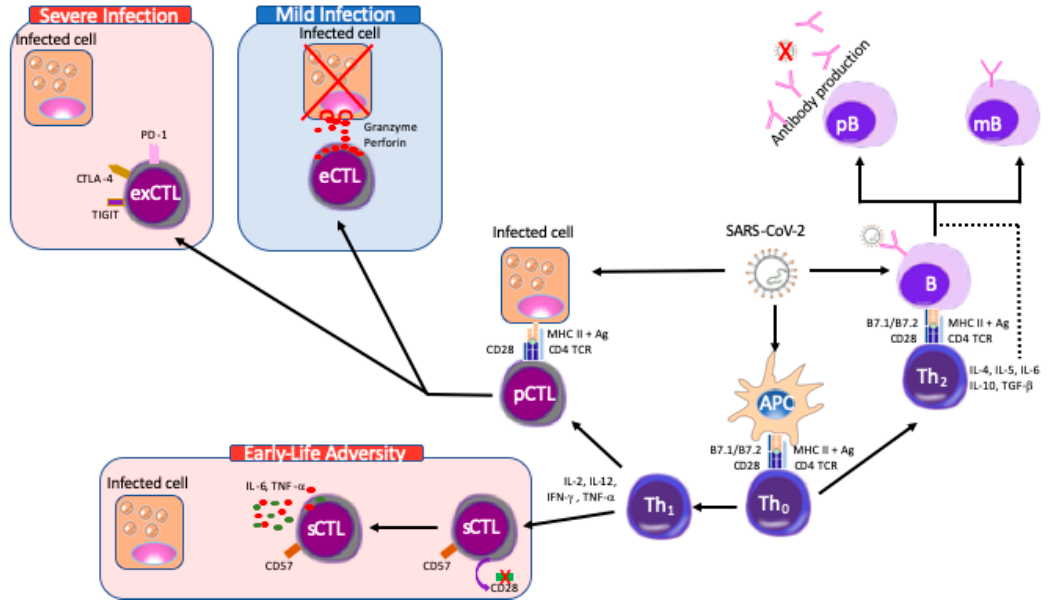
Figure 2. The immune reaction to coronavirus disease (COVID-19). The adaptive response to SARS-CoV-2 is a classical anti-viral response. On the right side, once recognized by antigen presenting cell (APC), Th 2 response is activated and induced maturation of B cell. After maturation precursor B cell produces a specific antibody against SARS-cov-2 while mature B cell retain memory of SAR-COV-2 to produce antibodies in case of new infection. Once the Th1 system is activated it induces activation of precursor cytotoxic lymphocyte T (pCTL) due to expression of many cytokines (IL-12, IL2). In one hand, effector (eCTL) can release proteins as granzyme to destroy infected cell in case of mild infection. In case of severe infection, CTL become exhausted (exCTL) and express PD-1, TIGIT and CTLA-4. In patients with having experienced ELA, the increased relative number of sCTL having lost CD28 expression will produce a less efficient lysis of SARS-CoV-2 infected cells. The recognition and clearance by NK cells and the initial role if Interferons is omitted for clarity. Cell images were from http://www.clker.com with the right to re-use them.